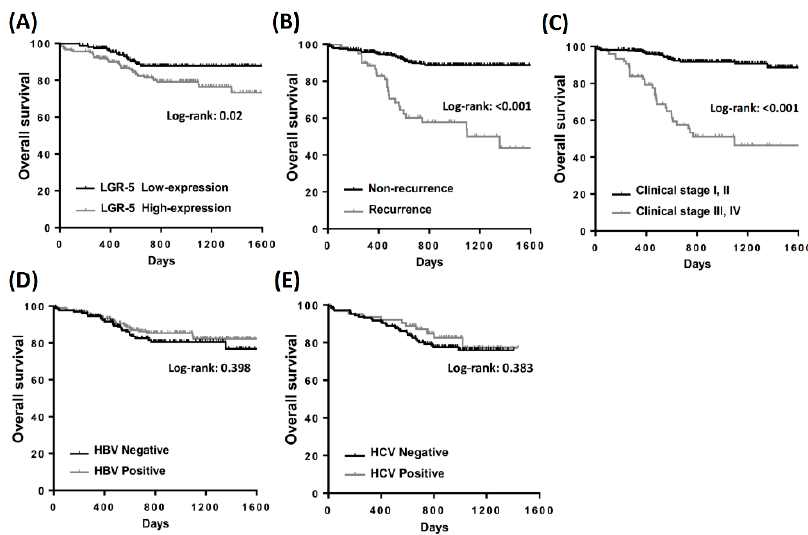
Figure 2. Kaplan–Meier analysis of the influence of ( A ) LGR-5 expression, ( B ) recurrence, ( C ) clinical stage, ( D ) hepatitis B virus infection, and ( E ) hepatitis C virus infection in total patients with HCC.